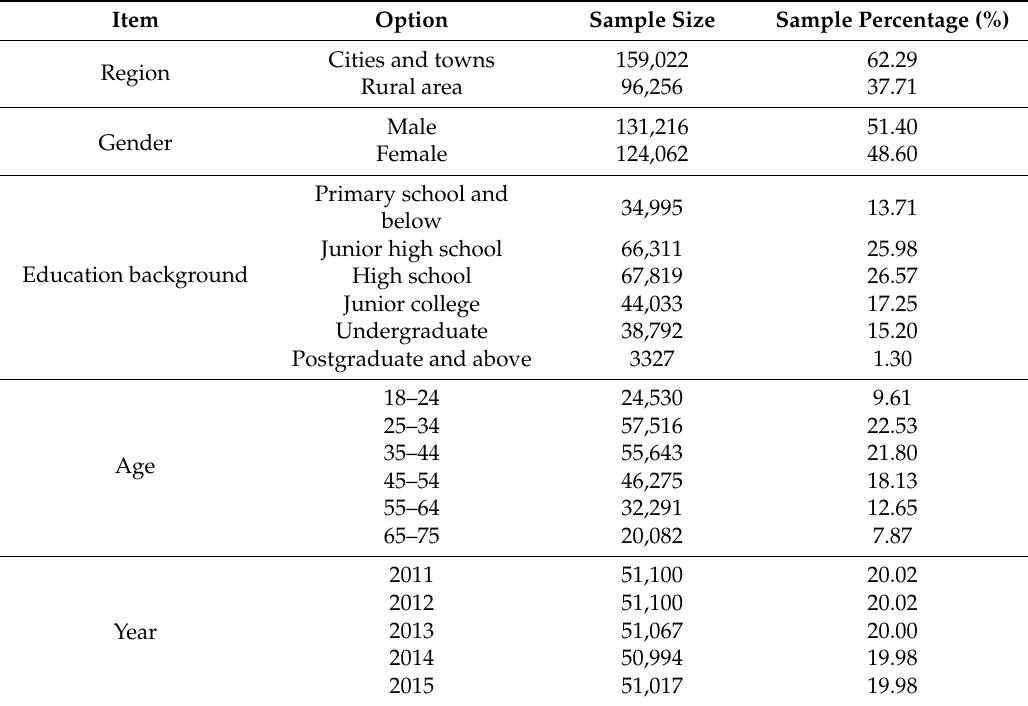
Table 1. Sample structure of telephone interview.